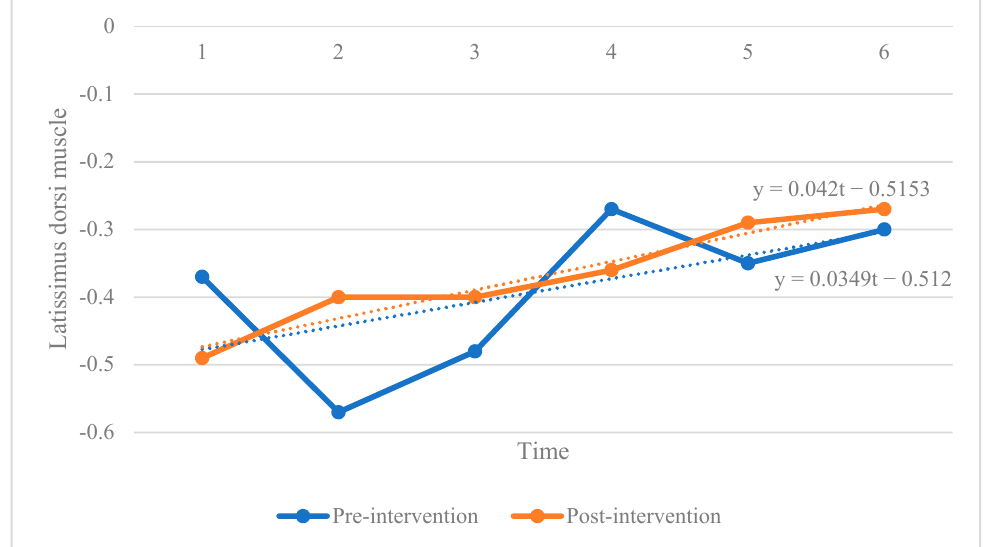
Figure 3. The effect of conventional intervention on number 1 athlete.